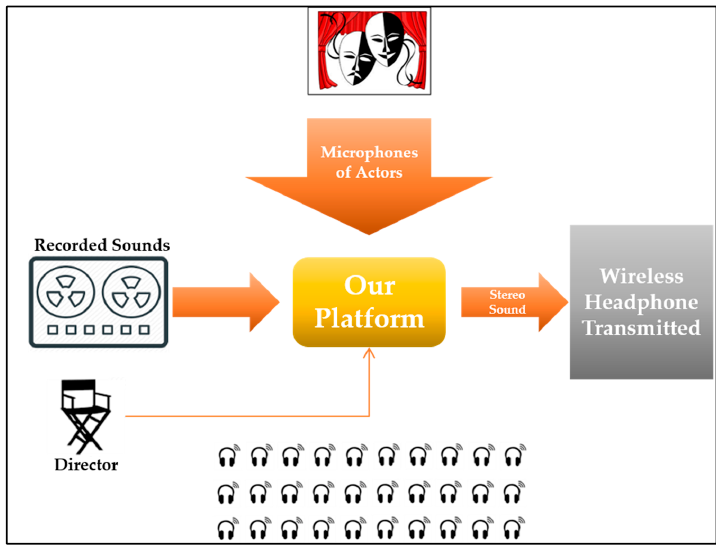
Figure 7. Use case scenario 2 — spatial/personalized sound with cohearing of the audience through individual headphones.